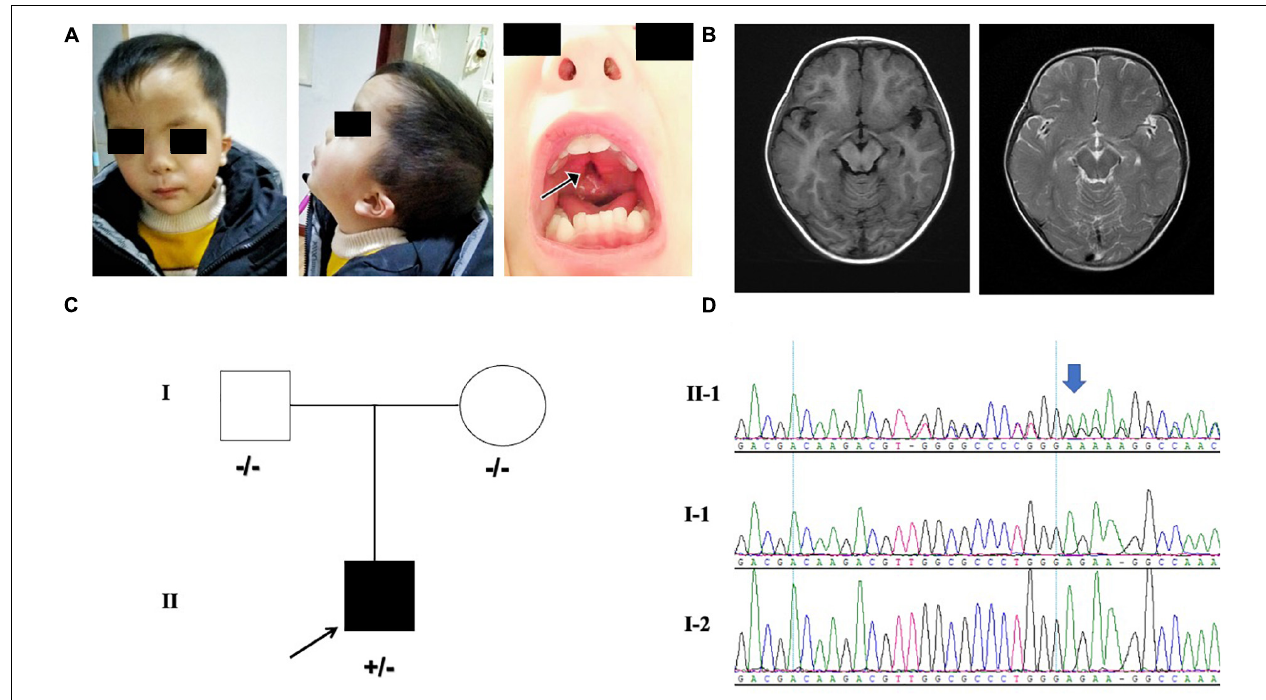
FIGURE 1 | (A) Facial features of the proband. The arrows point to the cleft palate. (B) MRI indicating the normal brain tissue and the protruding occipital bone (image on the left is axial T1-weighted; image on the right is axial T2-weighted) of the proband at 18-months-old. (C) Pedigree with MN1 variant. Individuals with heterozygous variants are indicated by plus/minus (+/–) symbols and individuals without the variant are labeled as minus/minus (–/–) symbols. (D) Sanger sequencing results of MN1 frameshift variant in family members is presented on the right.